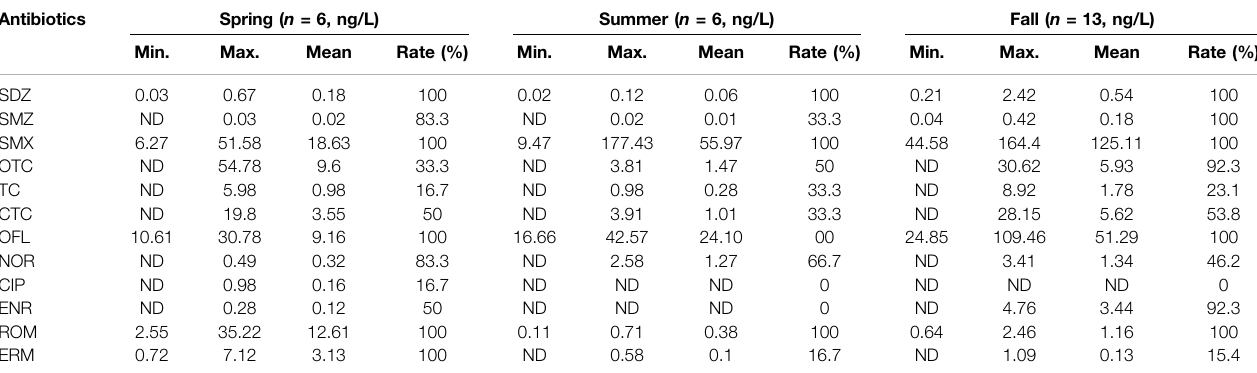
TABLE 2 | Contents of antibiotics in the surface sediment of East Dongting Lake. Antibiotics Spring ( n = 6, ng/L)